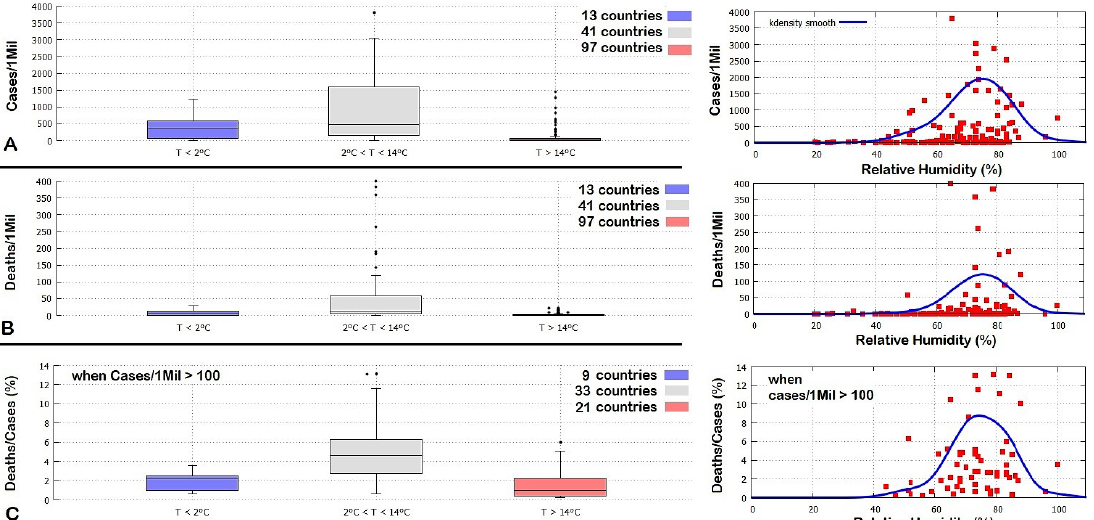
Figure 8. Left panels: Boxplots of country distribution in function of their March mean temperature, relative to the number of COVID-19 cases ( A ) and deaths ( B ) per million people, and the percent of deaths per cases ( C ). In ( C ) only the countries with more than 100 cases/1Mil were considered to reduce statistical volatility. See the supplementary file for the data. Right panels: equivalent scatterplots in function of the March mean relative humidity for the same countries (red) with the correspondent k density smooth function